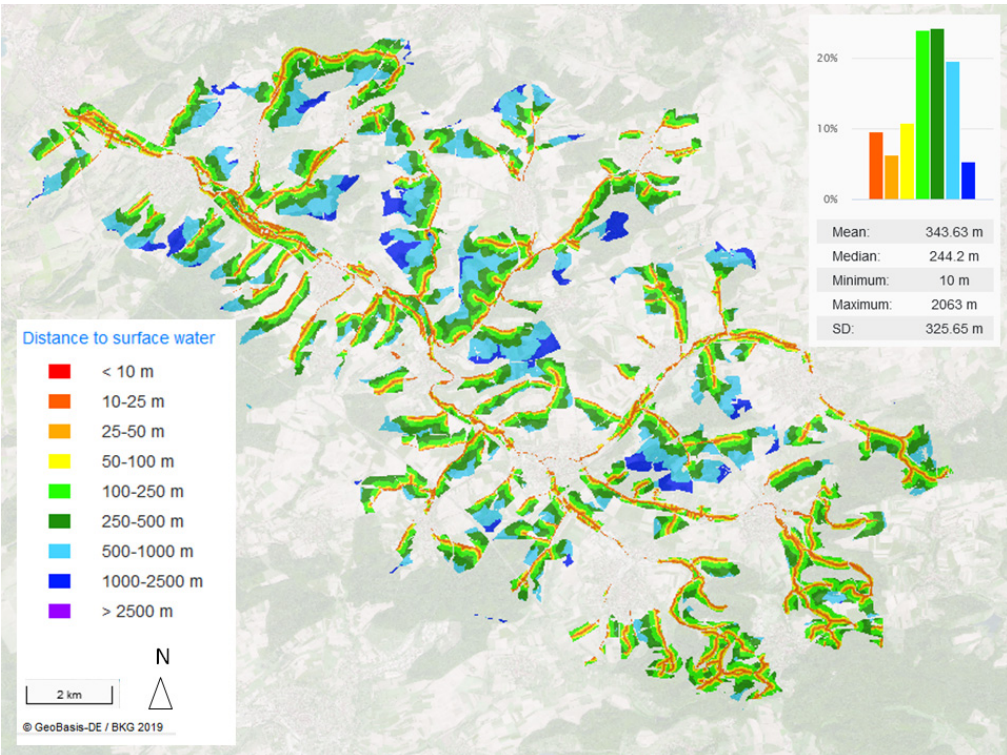
Figure 6. Modeled distance to water surface in the Kraichbach catchment.